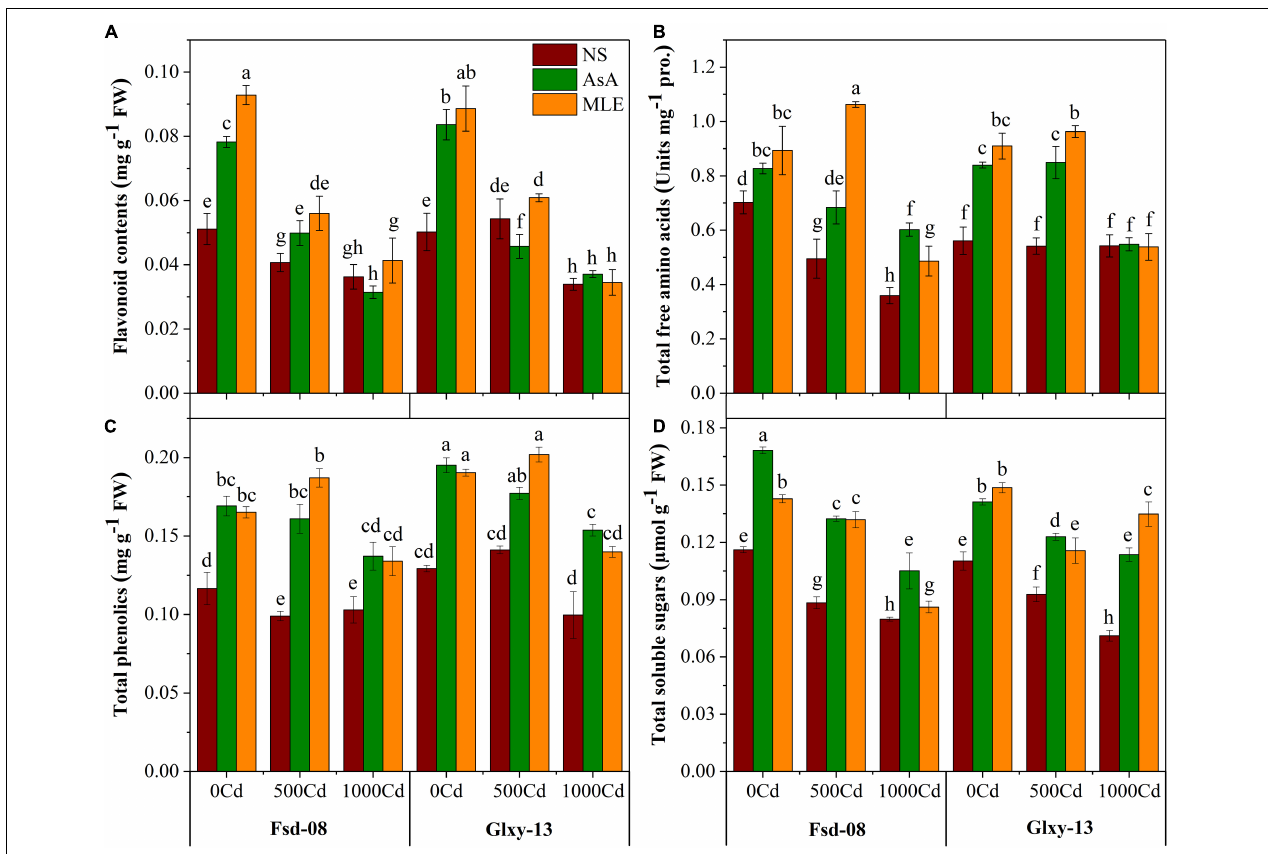
FIGURE 4 | Osmolyte accumulation responses as (A) flavonoid contents, (B) total free amino acid, total free amino acid (TFAA), (C) total phenolics, and (D) total soluble sugars, under the foliar spray of AsA and MLE, along with NS in two wheat cultivars (Fsd-08 and Glxy-13) exposed to the Cd toxicity. Different lowercase letters denote the significant difference as determined by LSD test ( p < 0.05, n = 4). AsA and MLE were applied at the rate of 50 mM and 3% (w/v),